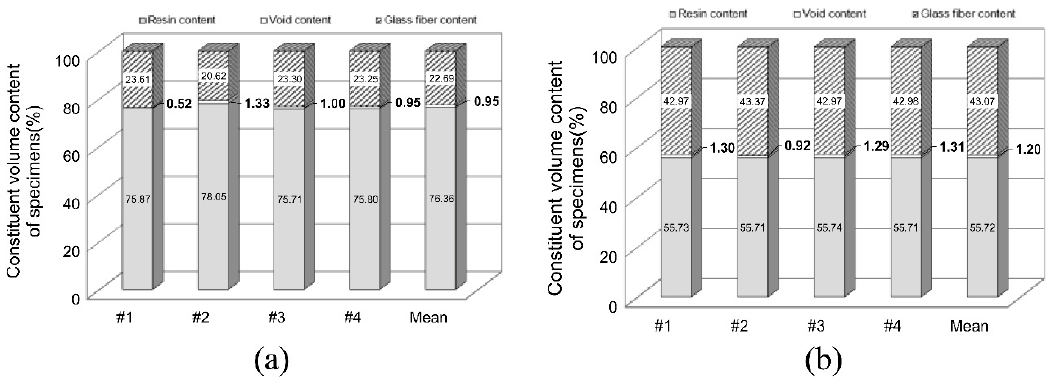
Figure 14. Volume fraction of voids in the specimens, measured by the burn-off method: ( a ) design Gc 40 wt.%; ( b ) design Gc 64 wt.%.